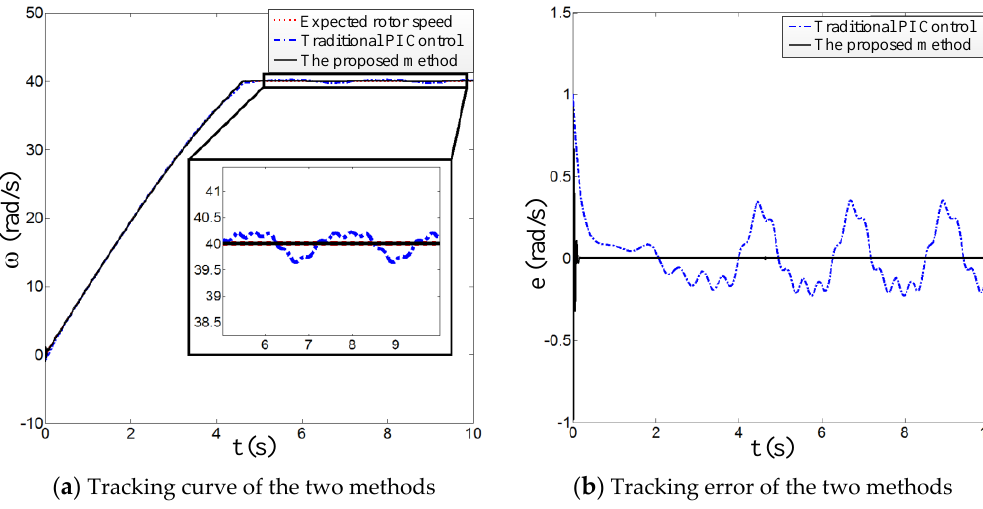
Figure 4. Tracking curve of the motor angular speed in the experiment.